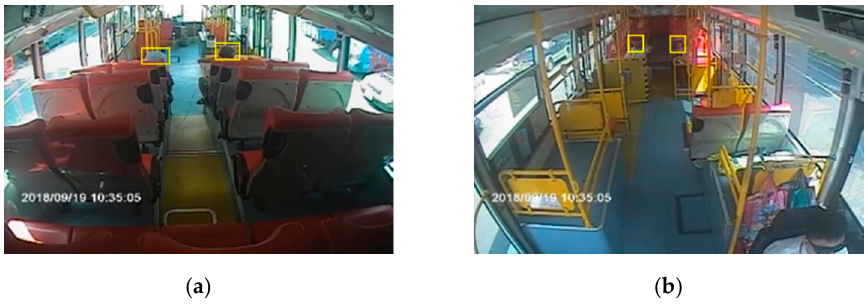
Figure 10. Seating area definition: ( a ) rear camera; ( b ) front camera.